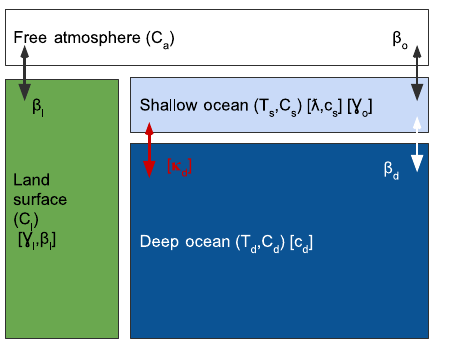
Figure A1. An illustration of the logic flow in the MiCES simple